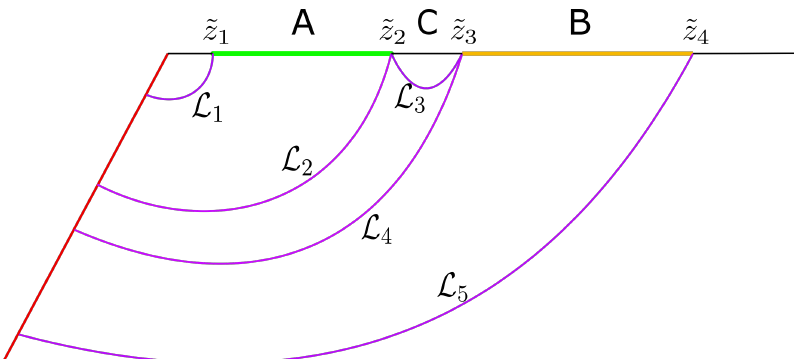
Figure 24. Geodesics contributing to the holographic entanglement negativity of disjoint intervals in